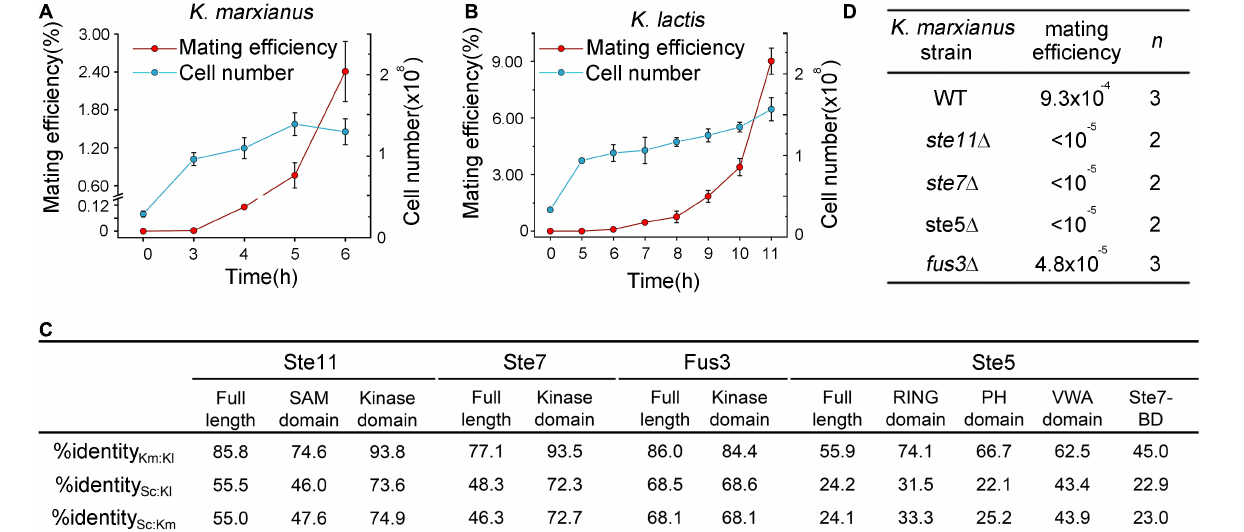
Frontiers in Microbiology |